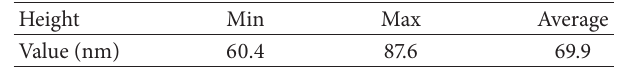
Table 2: Data of